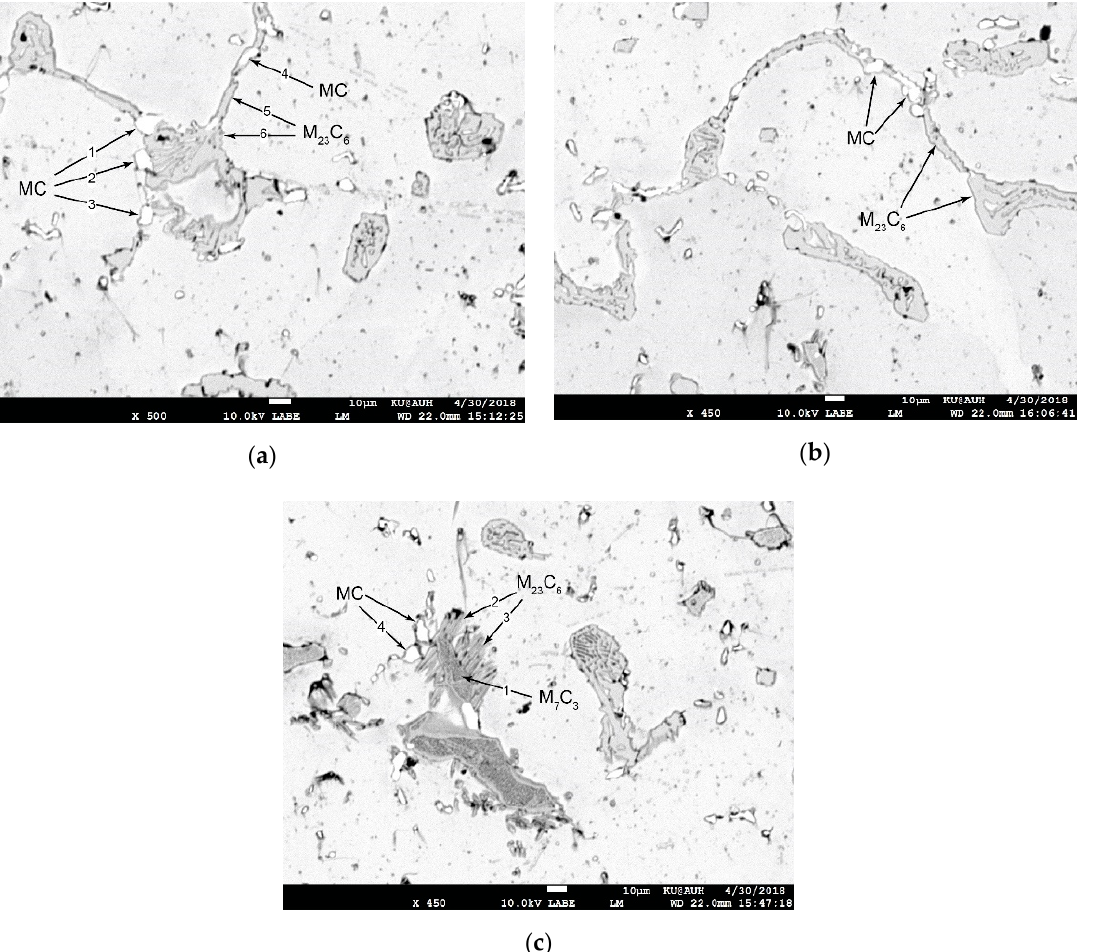
Figure 8. SEM-BSE images depicting: ( a , b ) MC and M 23 C 6 carbides in condition H5; ( c ) transformation of M 7 C 3 to M 23 C 6 carbide after creep exposure of 5 years. Numbers correspond to EDX composition analysis in Table 2.